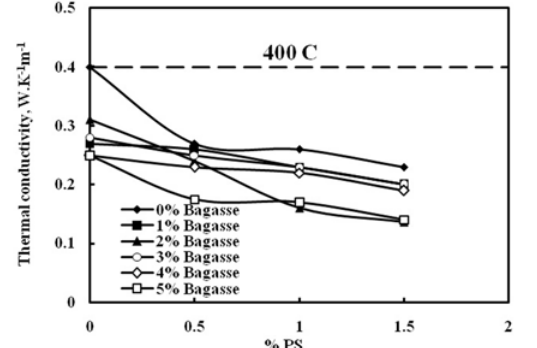
Figure 12. Effect of percent PS and Bagasse addition on thermal conductivity at 400 o C